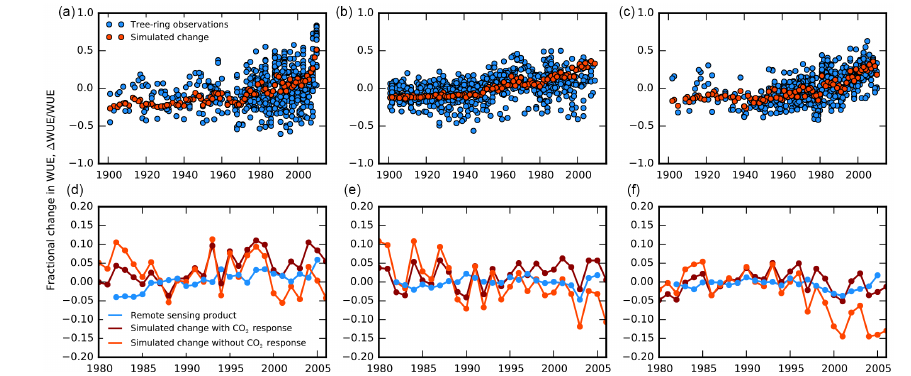
Figure 4. Comparison of estimated water-use efficiency trends to independent observations. Simulated fractional change in WUE (orange) compared to observations for three tropical tree-ring sites in Bolivia (a) , Cameroon (b) and Thailand (c) (blue, van der Sleen 2015). Simulated fractional change in WUE for (d) western North America, (E) western Europe and (F) East Asia, with (dark red) and without (orange) CO 2 effect, compared to the WUE trend derived from a remote sensing product of carbon uptake and water loss (Jung et al., 2011). The location of the tree-ring sites is presented in Fig. S1 and the regions (d) – (f) are as in Fig. 5.